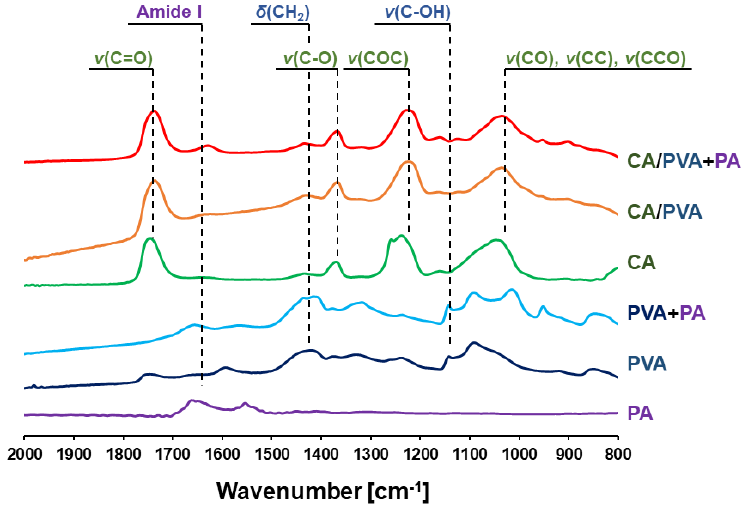
Figure 5. ATR-FTIR spectra of the electrospun